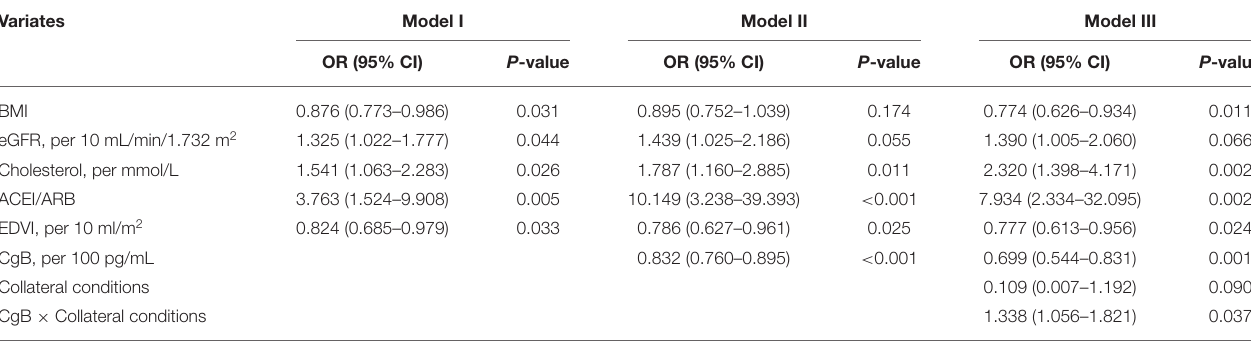
TABLE 3 | Multivariate analysis.